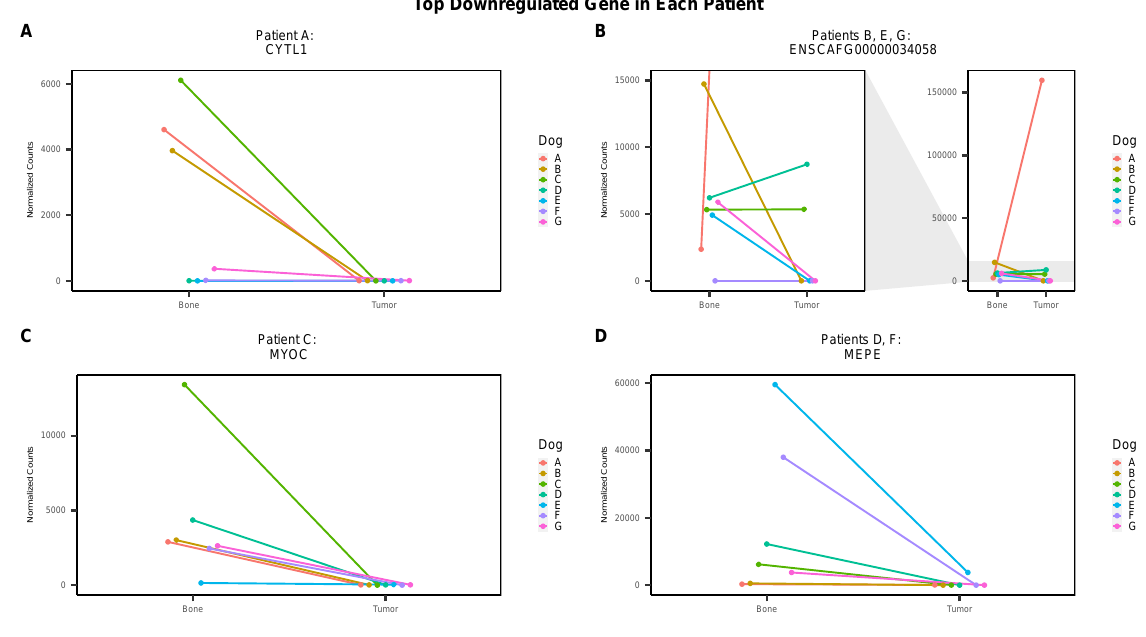
6A). The top downregulated gene for patients B, E, and G was ENSCAFG00000034058,